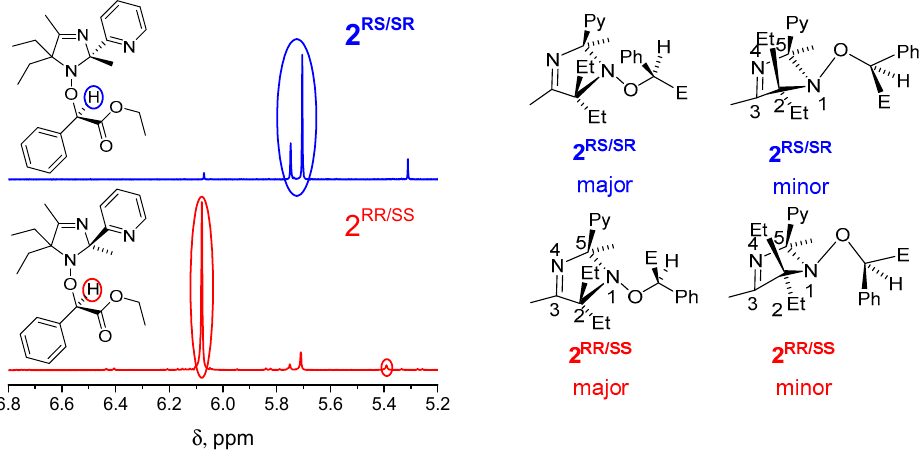
Figure 1. 1 H-NMR spectra in the region of the proton at the tertiary chiral carbon center for the two diastereomers 2 RS / SR and 2 RR / SS . For each diastereomer, the highlighted regions correspond to the respective invertomers.